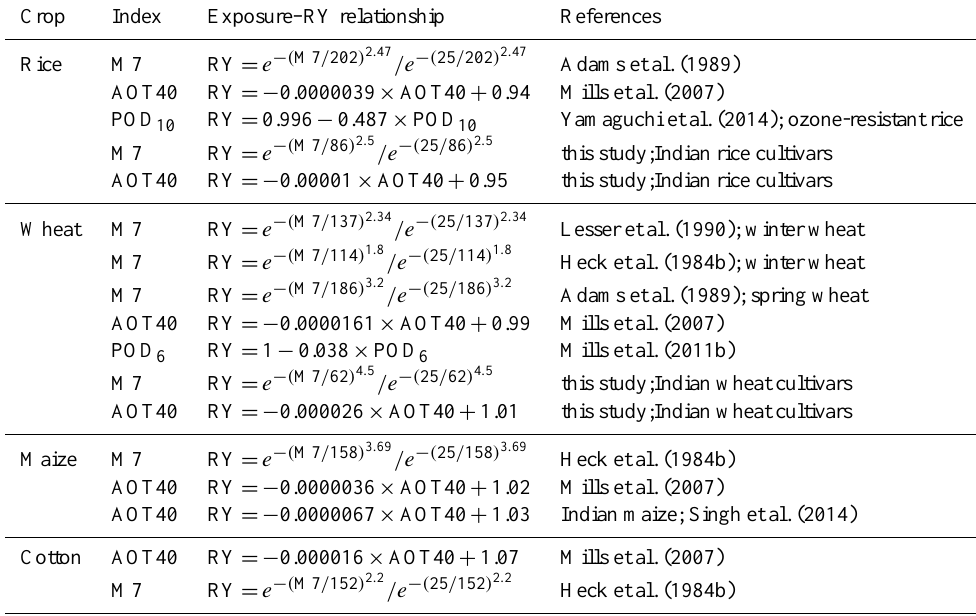
Table 2. Exposure–relative-yield (RY) relationships established in the literature and comparison with our own exposure–relative-yield rela- tionships. RY stands for relative